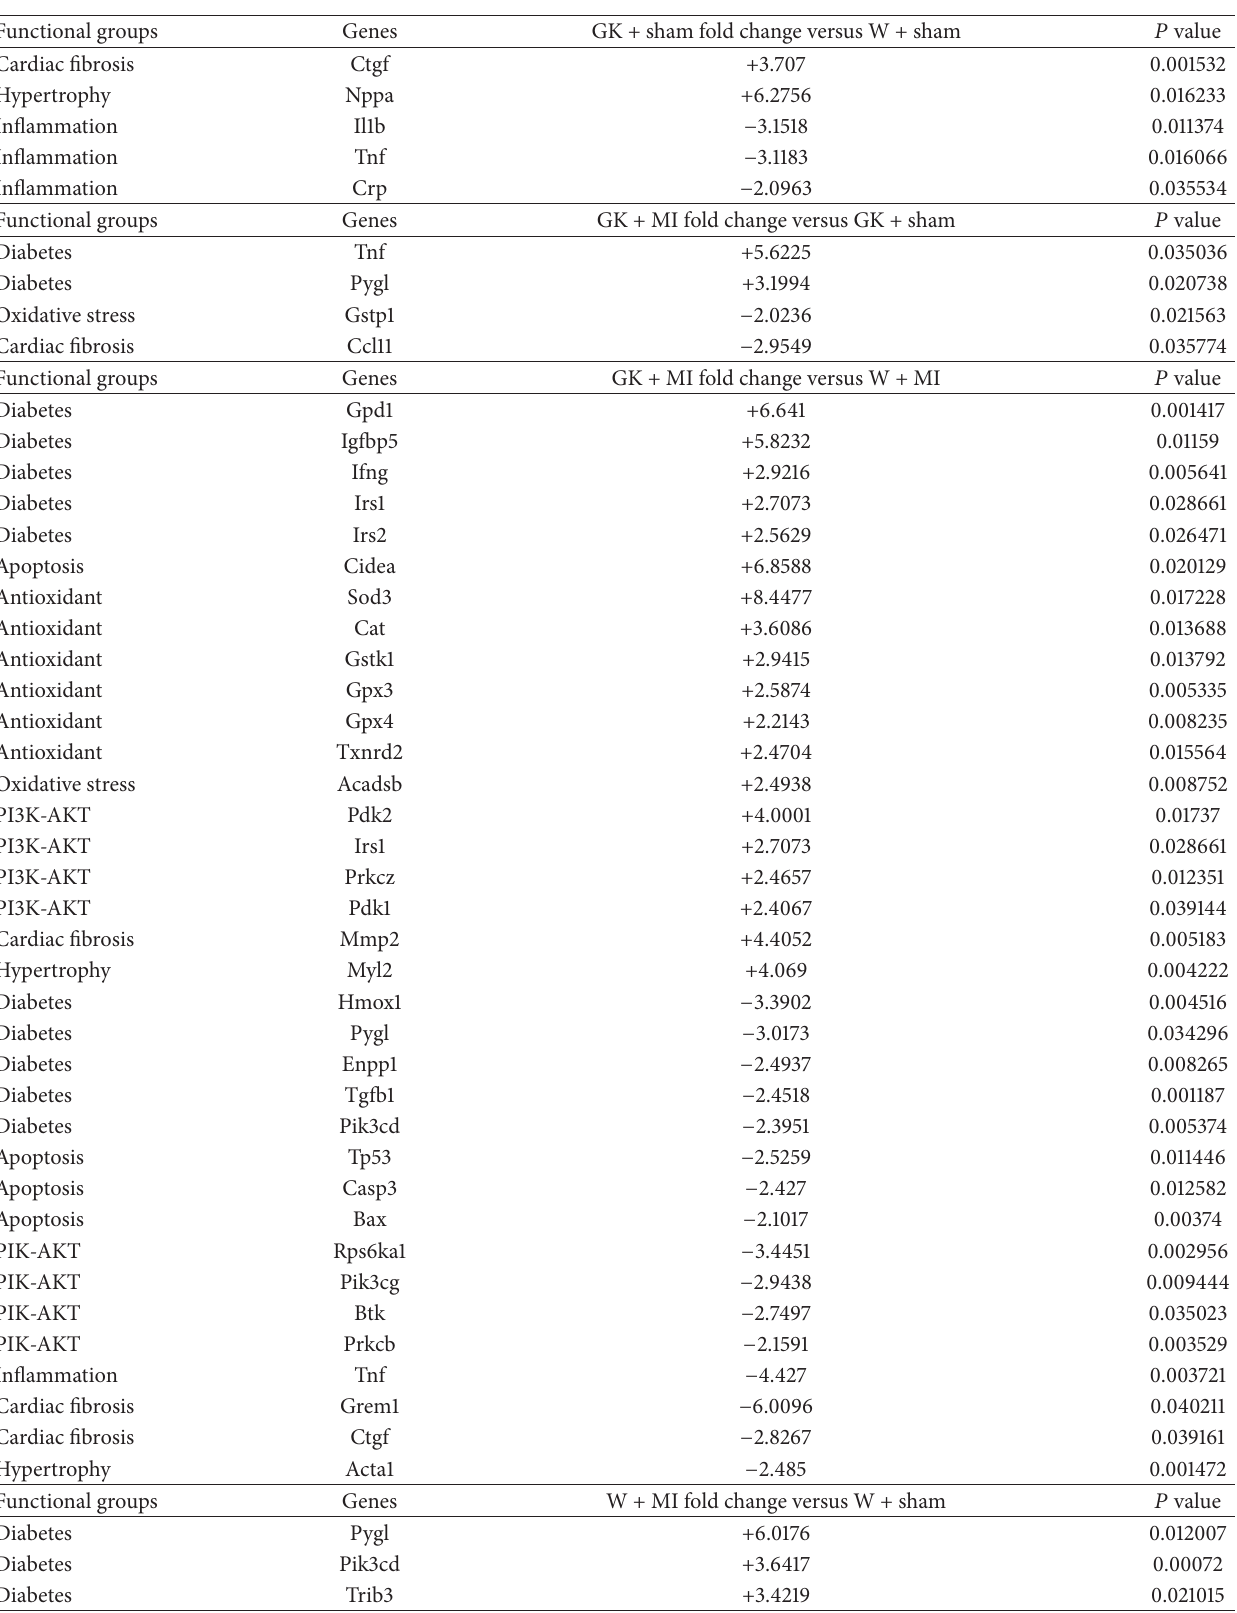
Table 4: Significant upregulated and downregulated genes in Goto-Kakizaki (GK) and control rats 24h after sham operation or myocardial infarction. MI indicates myocardial infarction; W: